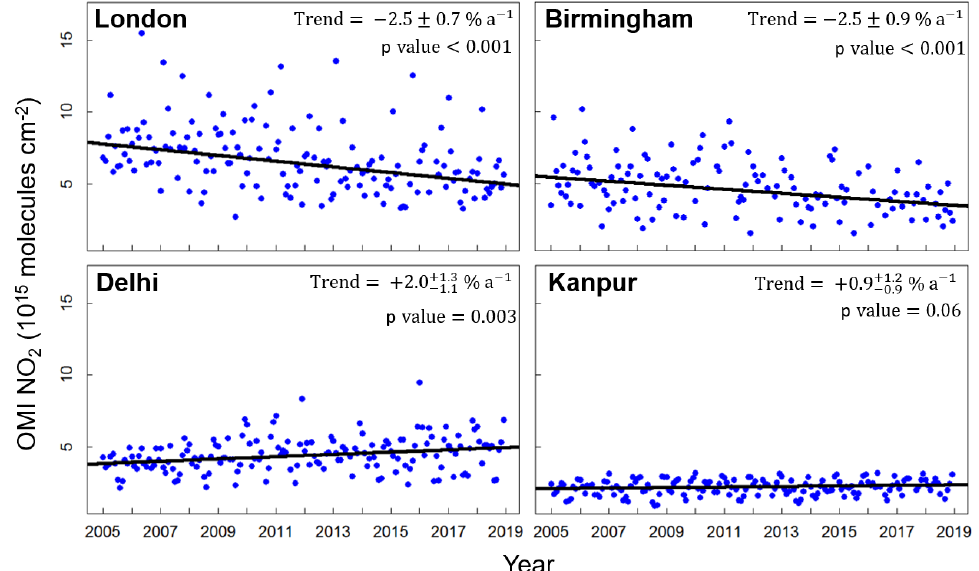
Figure 7. Time series of OMI NO 2 in 2005–2018 for London, Birmingham, Delhi, and Kanpur. Points are city-average monthly means. Black lines are trends obtained with the Theil–Sen single median estimator. Values inset are annual trends and p values. Absolute errors on the trends are the 95%